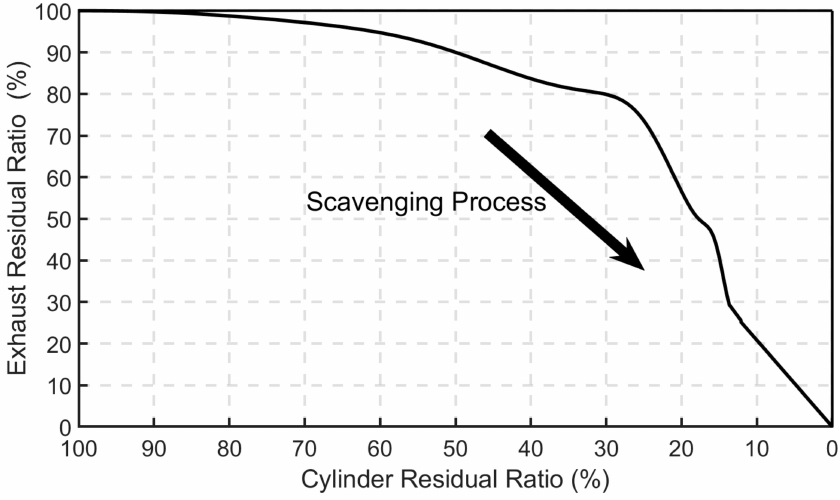
Figure 14. The scavenging profile.